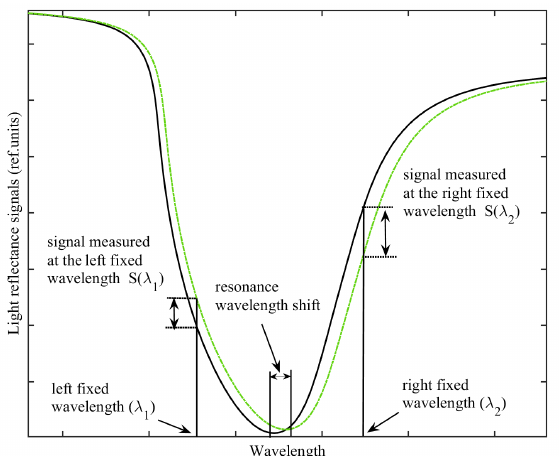
Figure 3. Dual-wavelength signal by shifting of the resonance curve.